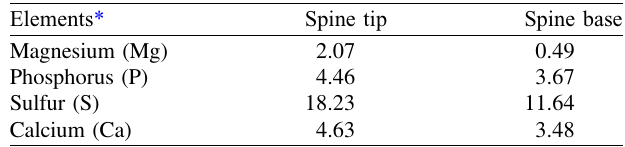
Table 4. X-ray scans for chemical elements of a Gallium cut small hook at the base of the proboscis of Rhadinorhynchus laterospinosus.